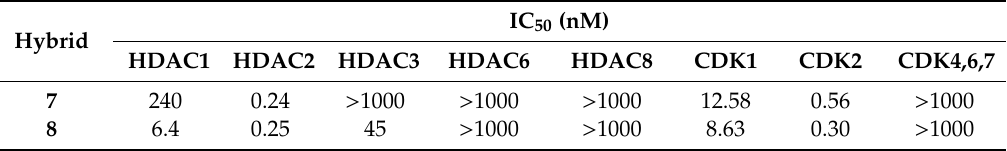
Table 1. Isoform selectivity of hybrids 7 and 8 against HDACs and